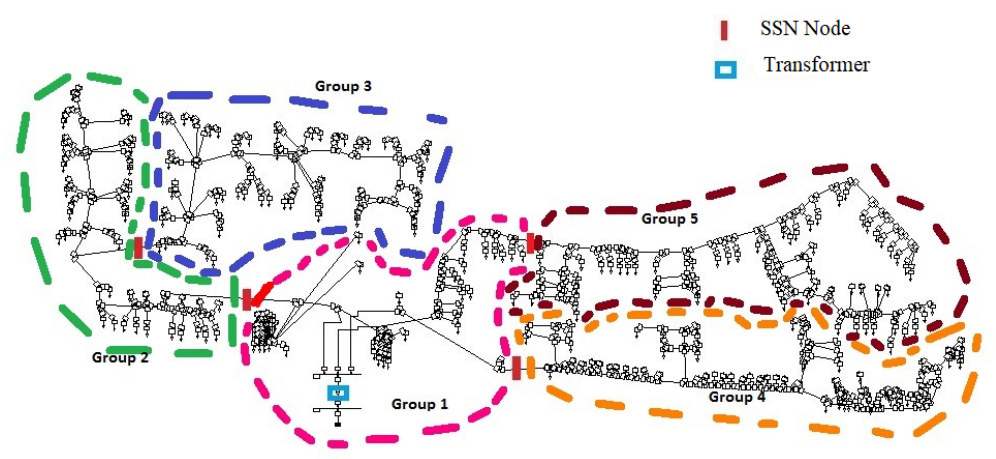
Figure 11. ENWLdistribution network in